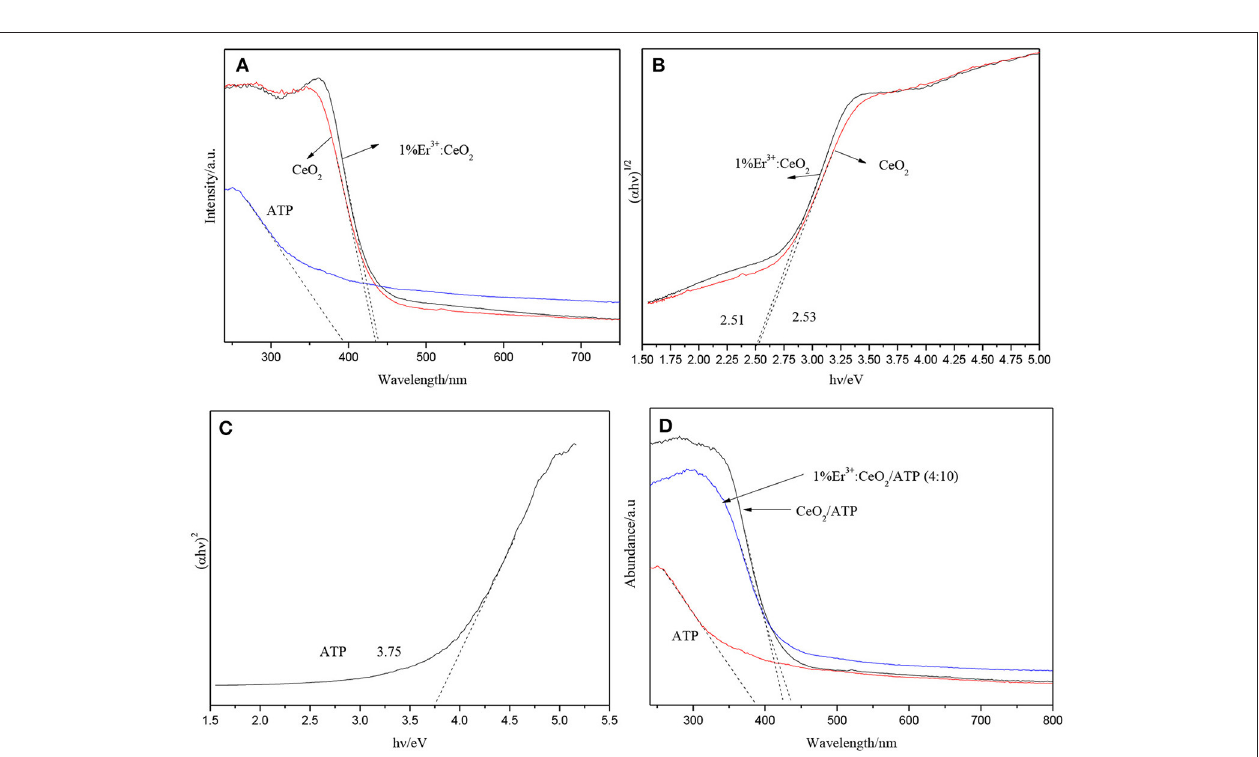
FIGURE 5 | UV–Vis patterns of ATP, CeO 2, and 1%Er 3 + :CeO 2 (A) , the plots of transformed Kubelka-Munk function vs. light energy of CeO 2, and 1%Er 3 + :CeO 2 (B) , the plots of transformed Kubelka-Munk function vs. light energy of ATP (C) , and the UV–Vis patterns of ATP, CeO 2, and 1%Er 3 + :CeO 2 (4:10) (D) .